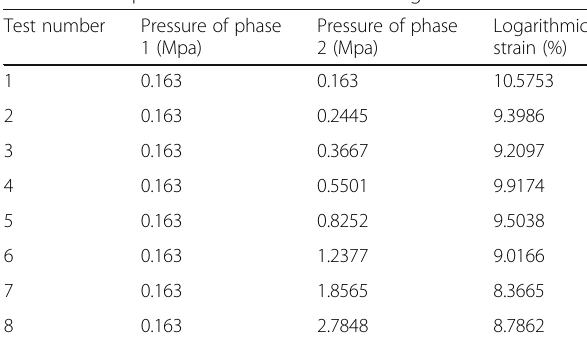
Table 8 Trial and error related to the blank pressure change between two phases and variations of the logarithmic strain